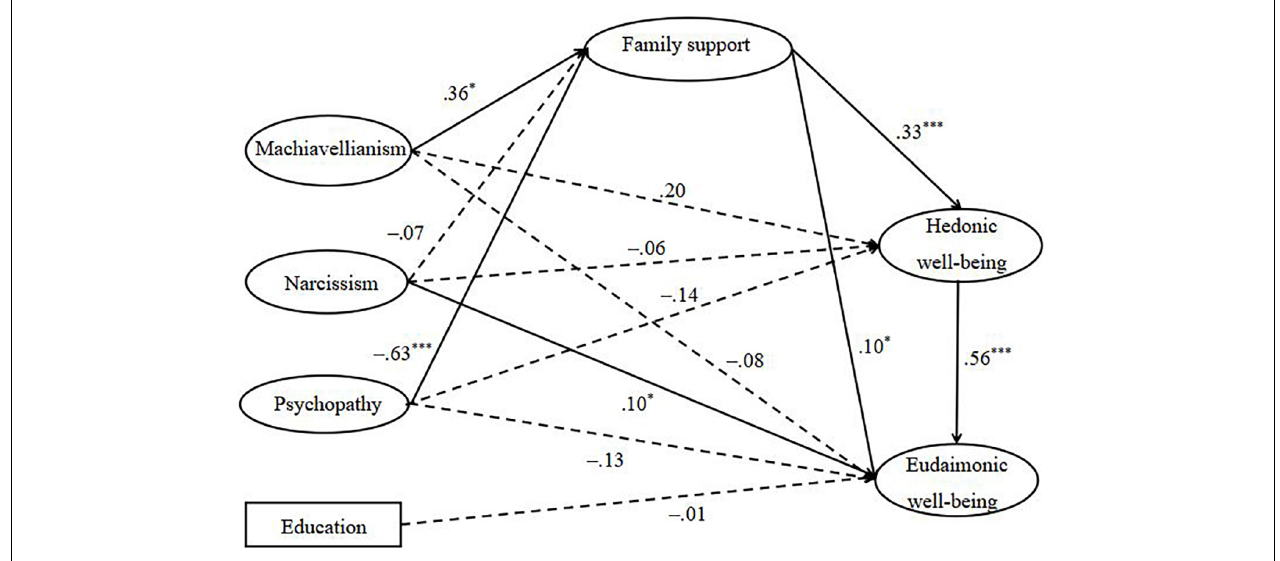
FIGURE 1 | The role of the DarkP Triad Trait on eudaimonic wellbeing of individuals via perceived family support and hedonic well-being. Values presented are standardized coefficients. The dash lines represent non-significant paths. Endogenous error correlations and control variables have not been drawn for parsimony. ∗ p < 0.05, ∗∗∗ p <